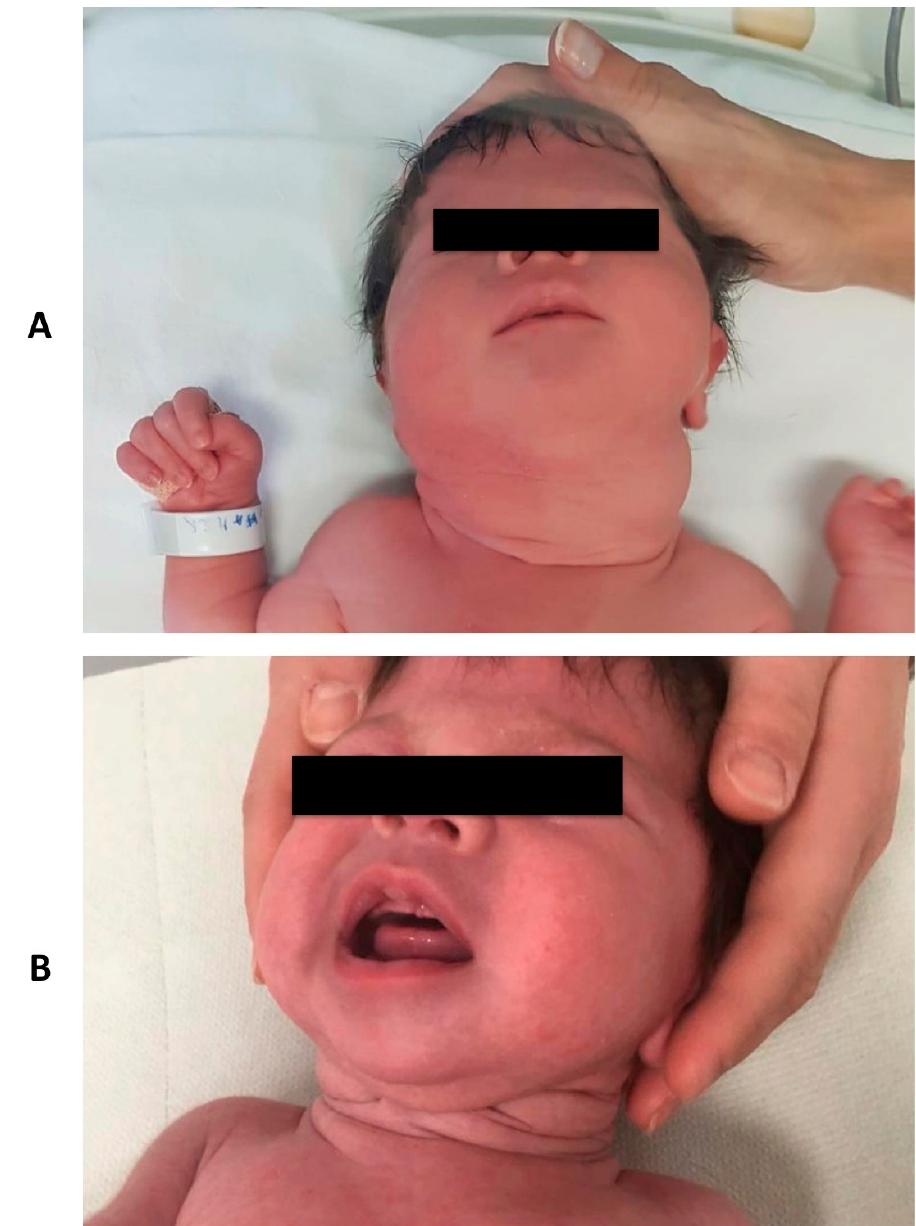
Figure 1. Clinical aspect of the neck mass at birth (Panel A ) and at three months follow-up (Panel B ). Ultrasound showed an enlargement of the thyroid gland (antero–posterior diameter of the right lobe was 2.5 cm and the left one was 2.2 cm, Figure 2), with a normal echogenic pattern and increased blood flow with central vascularization.